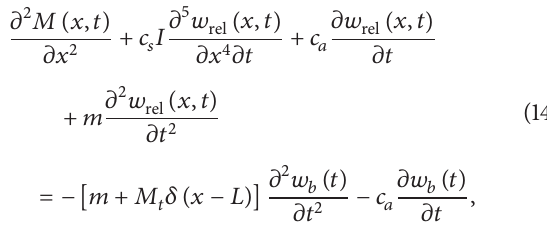
Figure 4: Scheme of the bimorph piezoelectric beam.